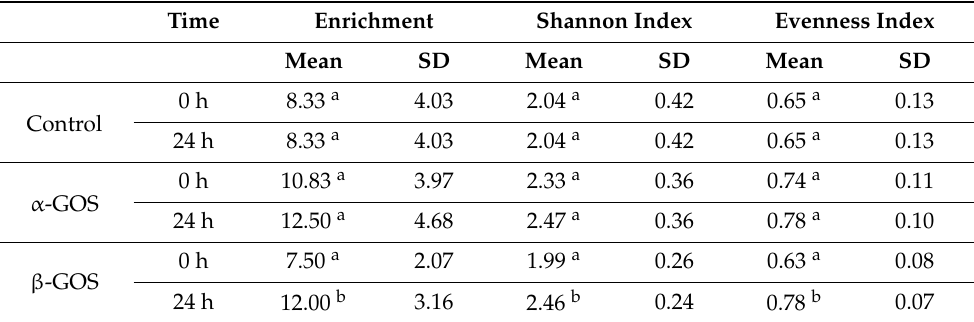
Table 3. Diversity indices of bifidobacterial samples after non-fructosylated α -GOS and β -GOS 24 h treatment of infant faecal